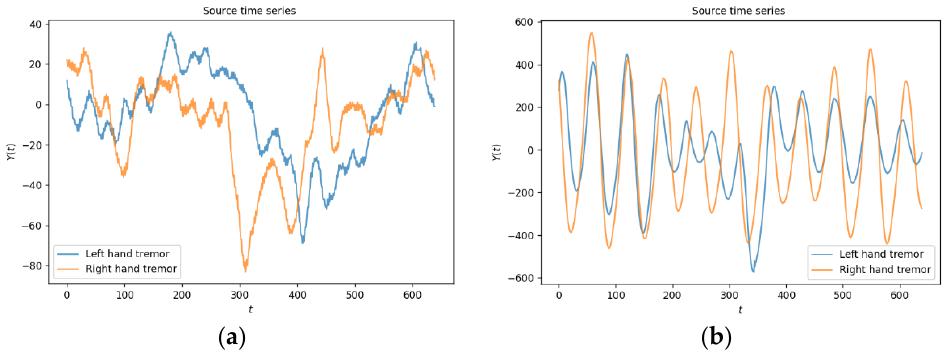
Figure 1. The signal received from the strain gauge module: ( a ) patient without any pathology detected; ( b ) patient with CNS pathology.